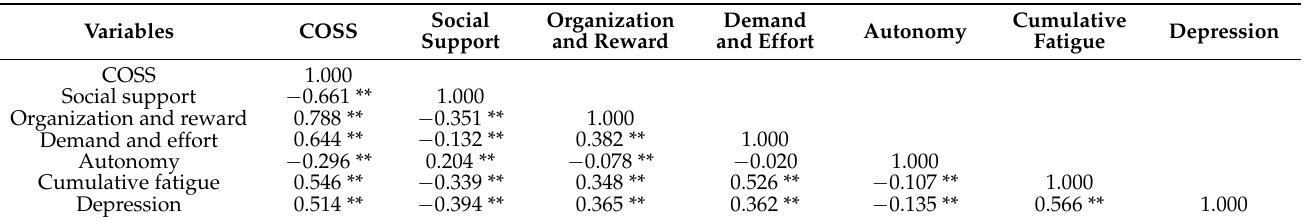
Table 5. Correlation analysis of occupational stress, cumulative fatigue, and depressive